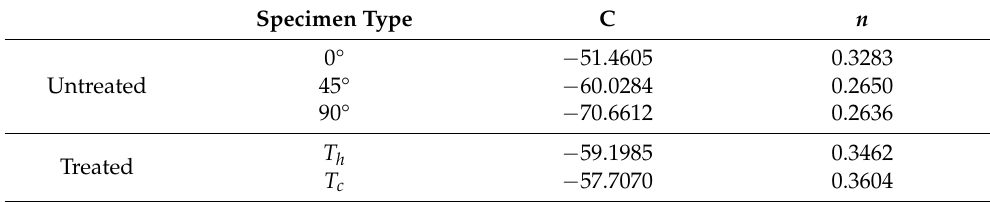
Table 8. Findley model parameters for the treated and unconditioned